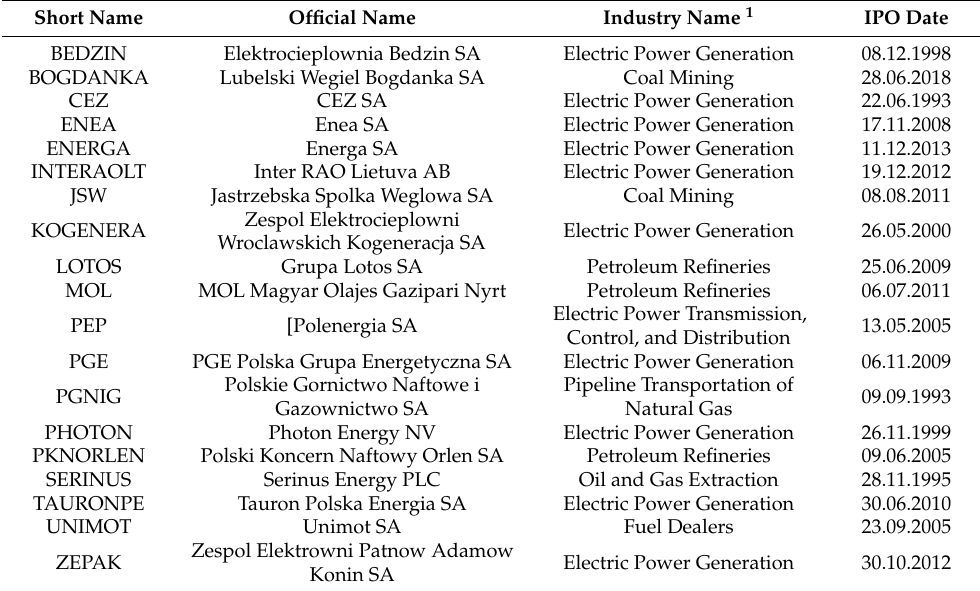
Table 3. Polish stock energy